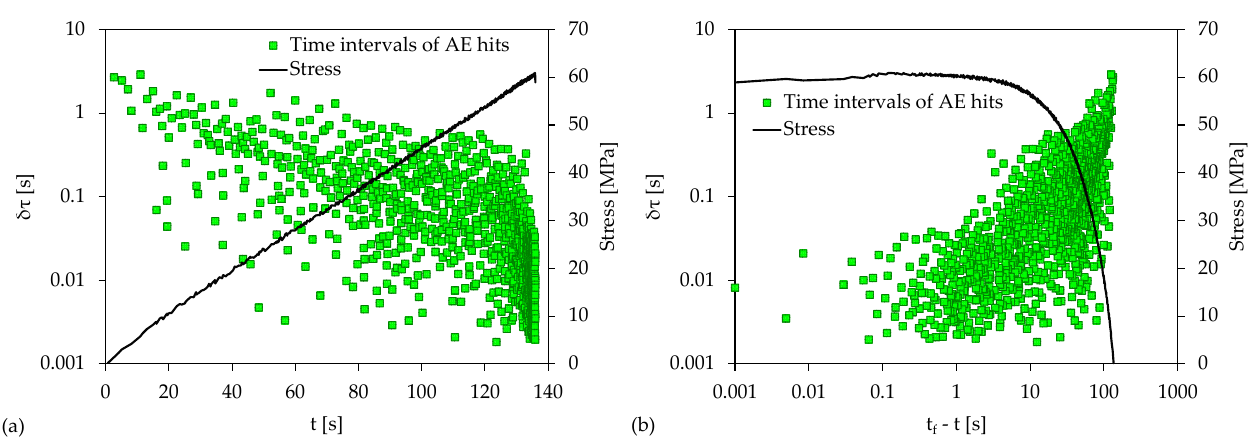
(cid:16) (cid:17) ( ) t f − t time-scale parameter for the case of the UC t t − time-scale parameter for the case of f